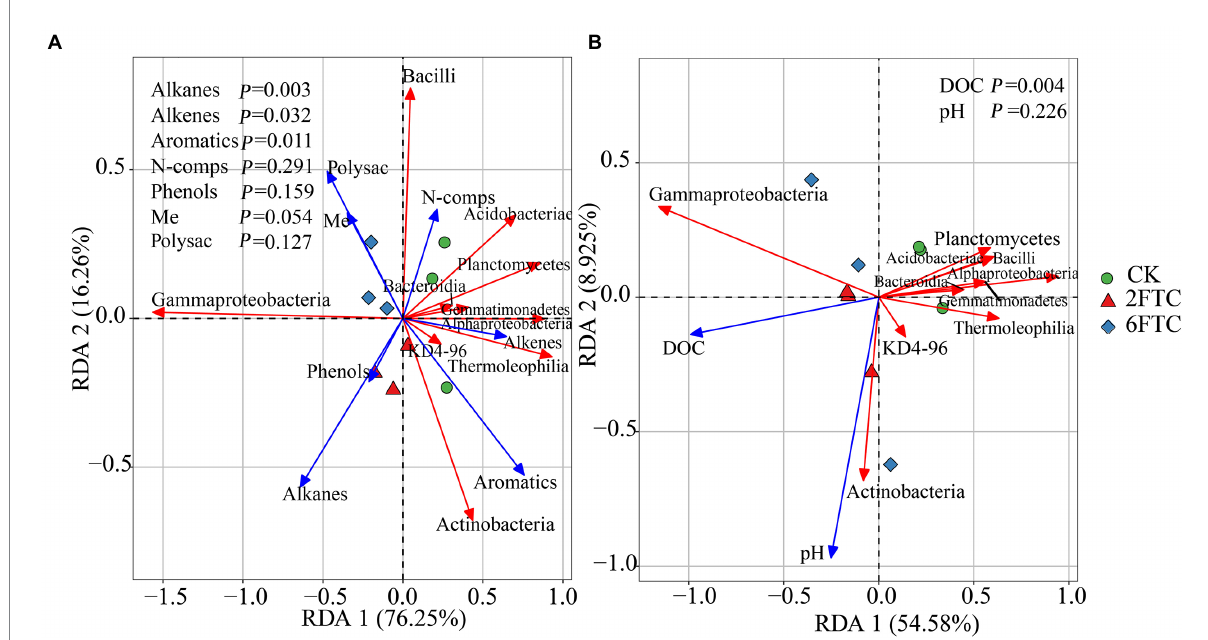
FIGURE 7 Redundancy analysis (RDA) of soil bacterial community composition at the class level as a function of soil chemical properties in (A) 0–10 cm and (B) 50–60 cm. Blue vectors represent trajectories of soil chemical properties; Red vectors represent dominant bacterial classes. Soil chemical parameters with significant effects on major bacterial classes were assessed at the 0.05 level (Monte Carlo tests with 999 permutations).